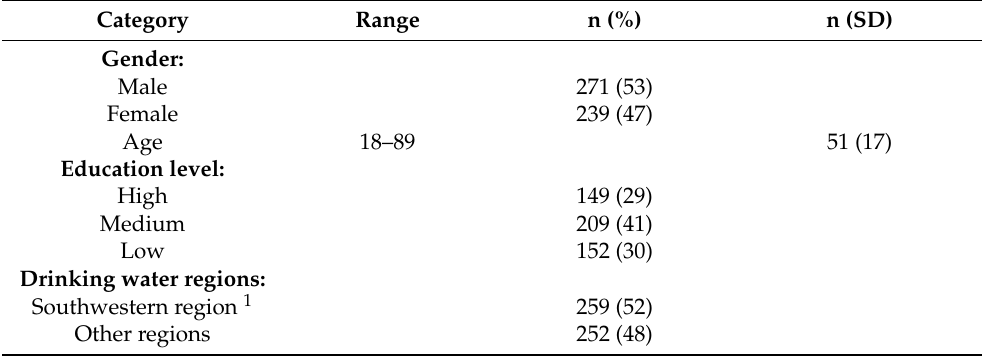
Table 2. Demographic characteristics of the study sample.